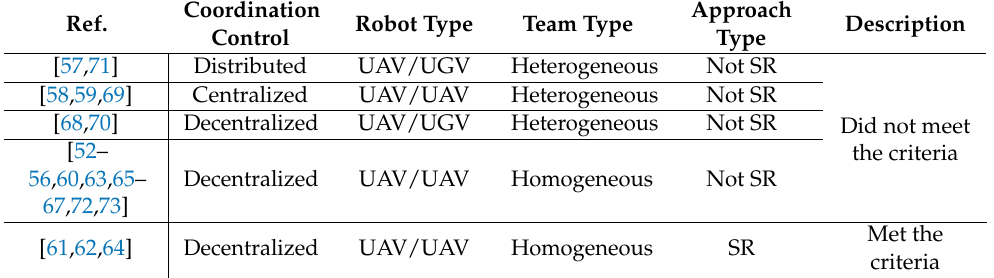
Table 12. List of papers based on system approaches.